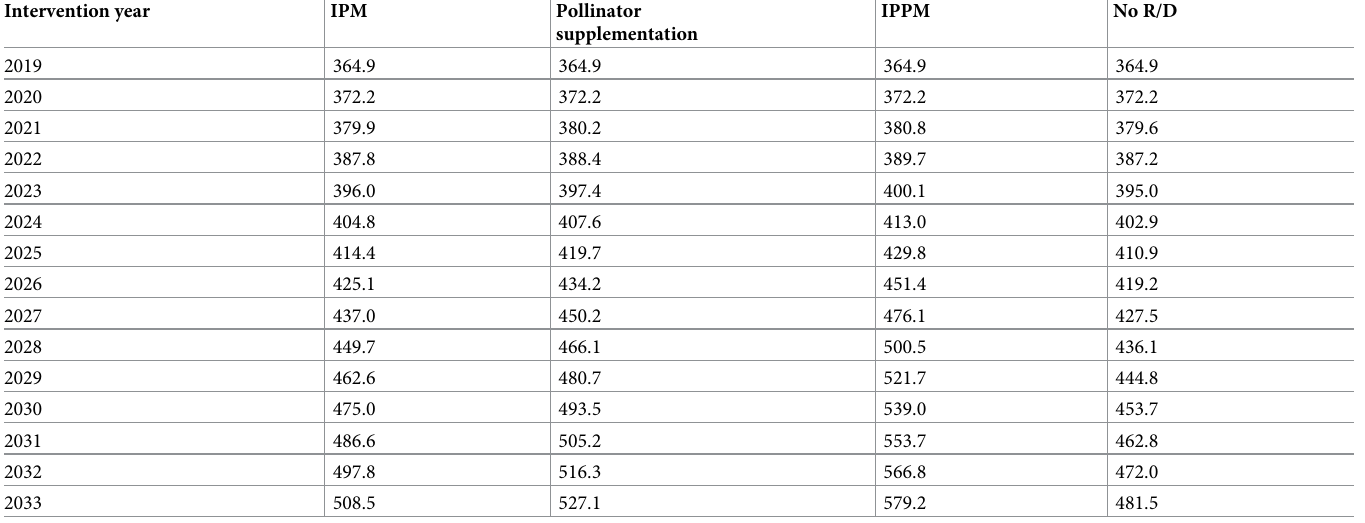
Table 4. Simulated changes in quantity produced under the IPM, pollinator supplementation, and IPPM interventions in Kenya (‘000 tonnes). Intervention